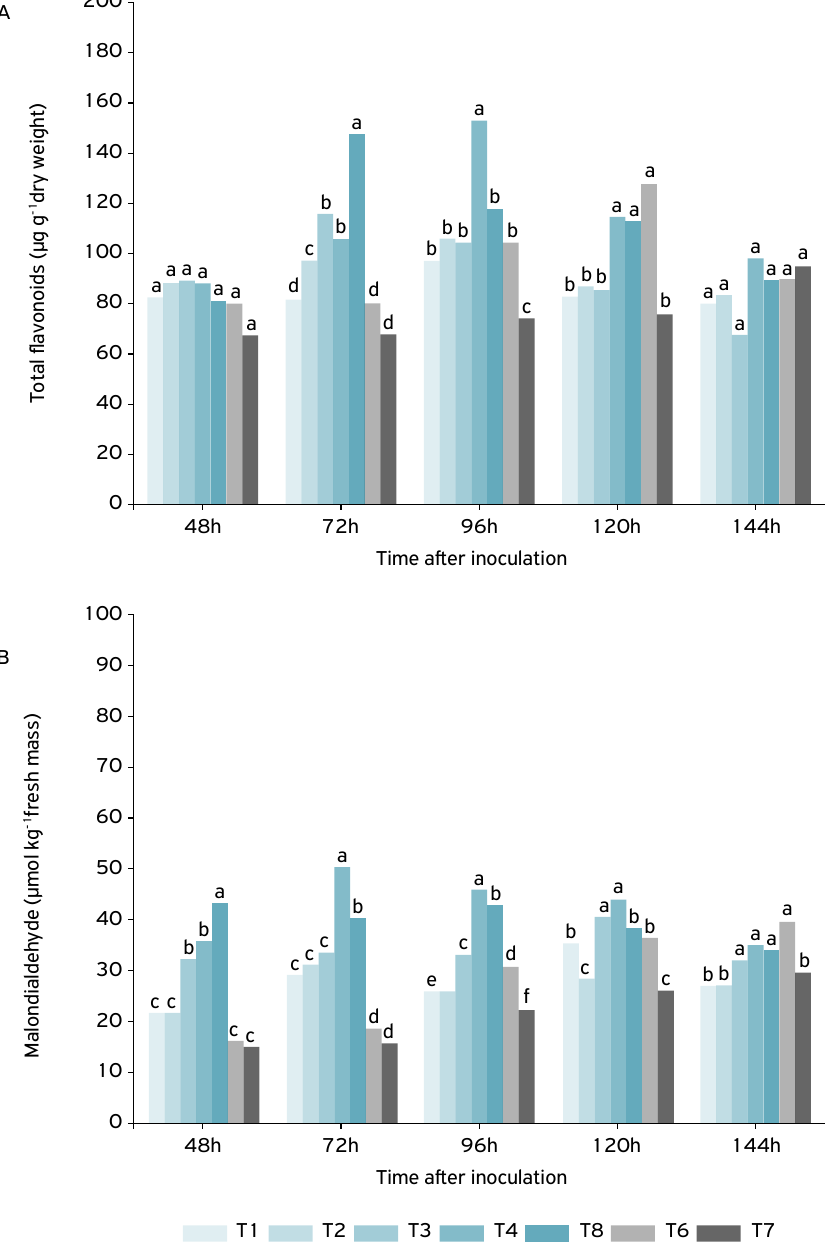
Averages followed by distinct letters between treatments differ by the Scott-Knott test at the 5% probability level; T1: suspension of Aspergillus japonicas ; T2: suspension of Trichoderma tomentosum ; T3: salicylic acid; T4: acibenzolar-s-methyl; T5: fungicide (Azoxystrobin with Tebuconazole); T6: application of sterile distilled water with inoculum of Bipolaris sorokiniana ; T7: without any Figure 6. Amount of (A) total flavonoids and (B) malondialdehyde, after inoculation of the Bipolaris sorokiniana pathogen.